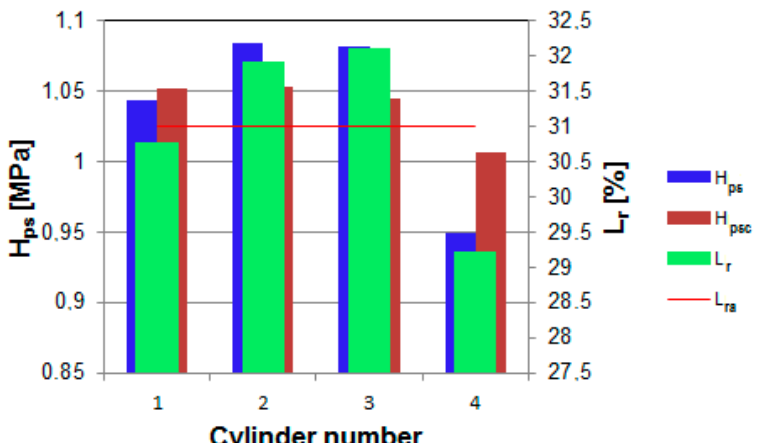
Figure 12. Values of the diagnostic symptom of in-cylinder pressure in the frequency domain H ps for similar relative loads L r of the engine and values of corrected amplitudes H psc for the average load L ra .